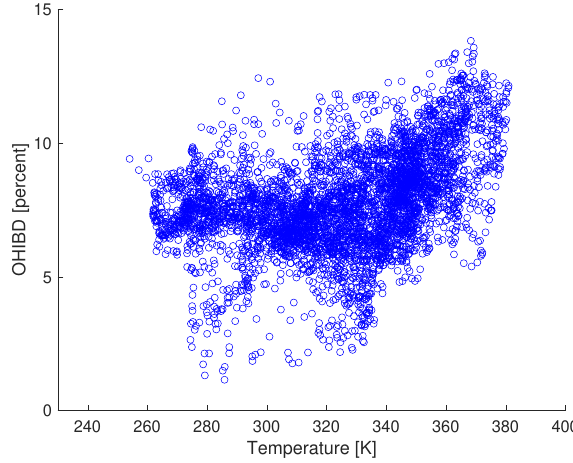
Figure 10. The temperature and the OHIBD value at the Theophilus region show a moderate correlation of r = 0.4.